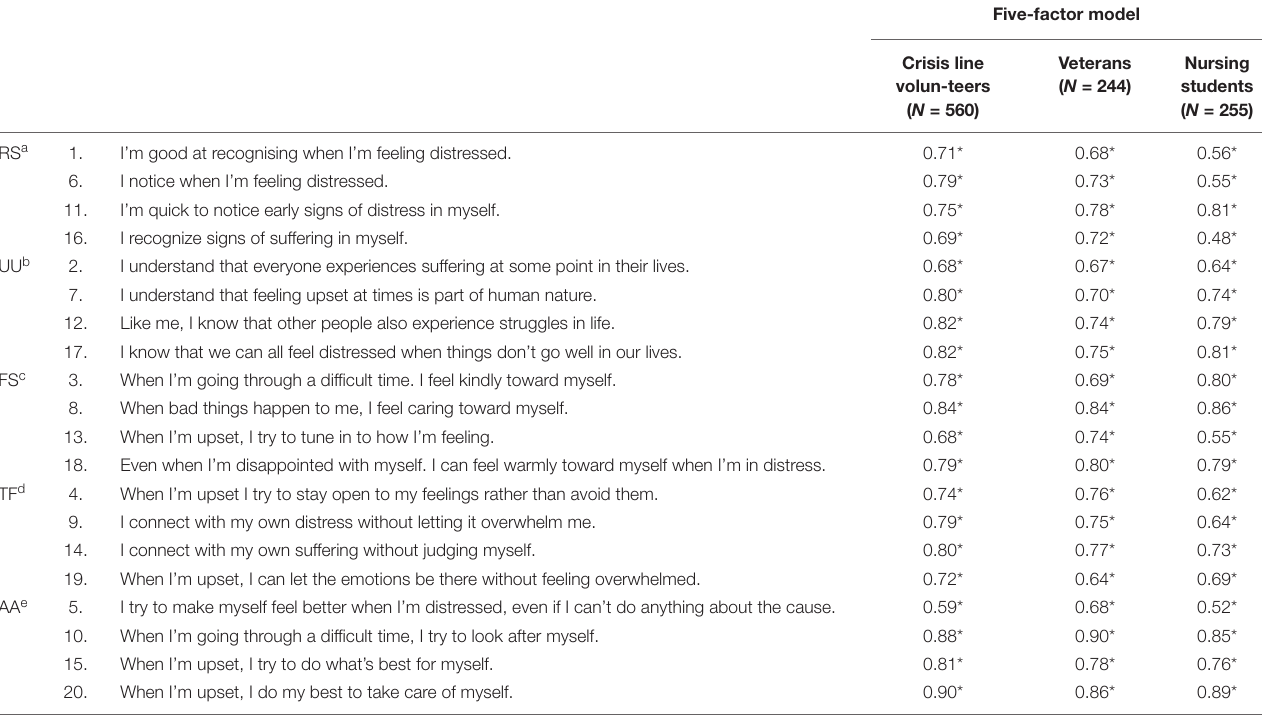
TABLE A1 | Factor loadings of all items on the five-factor